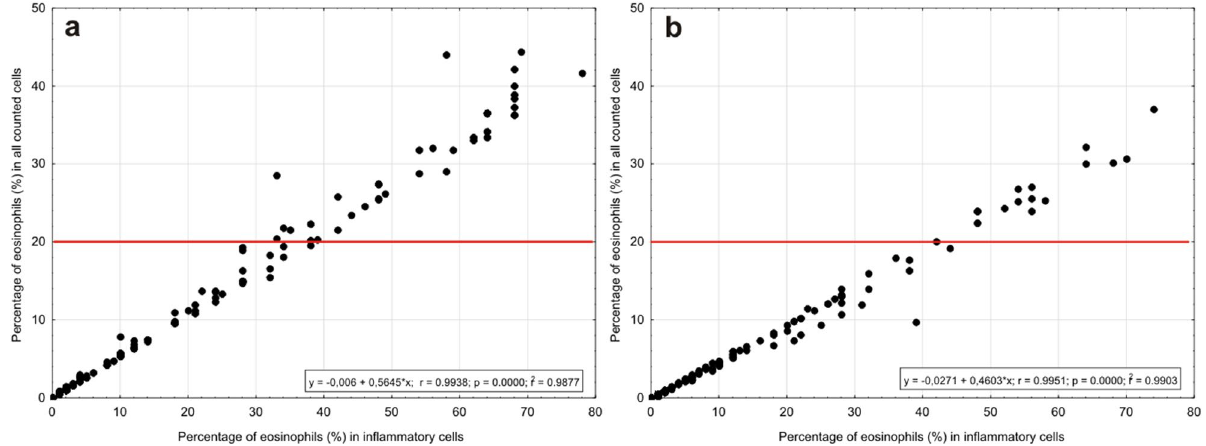
Figure 4. Relationship between percentage of eosinophils counted in all and in inflammatory cells, in ( a ) patients with a normal cytogram (Epith:Infl > 1) and ( b ) with inflammation picture (Epith:Infl ≤ 1). The red horizontal line corresponds with the level of eosinophils in all counted cells, recommended for the diagnosis of non-allergic rhinitis acc. to Heffler et al. (2018) 1